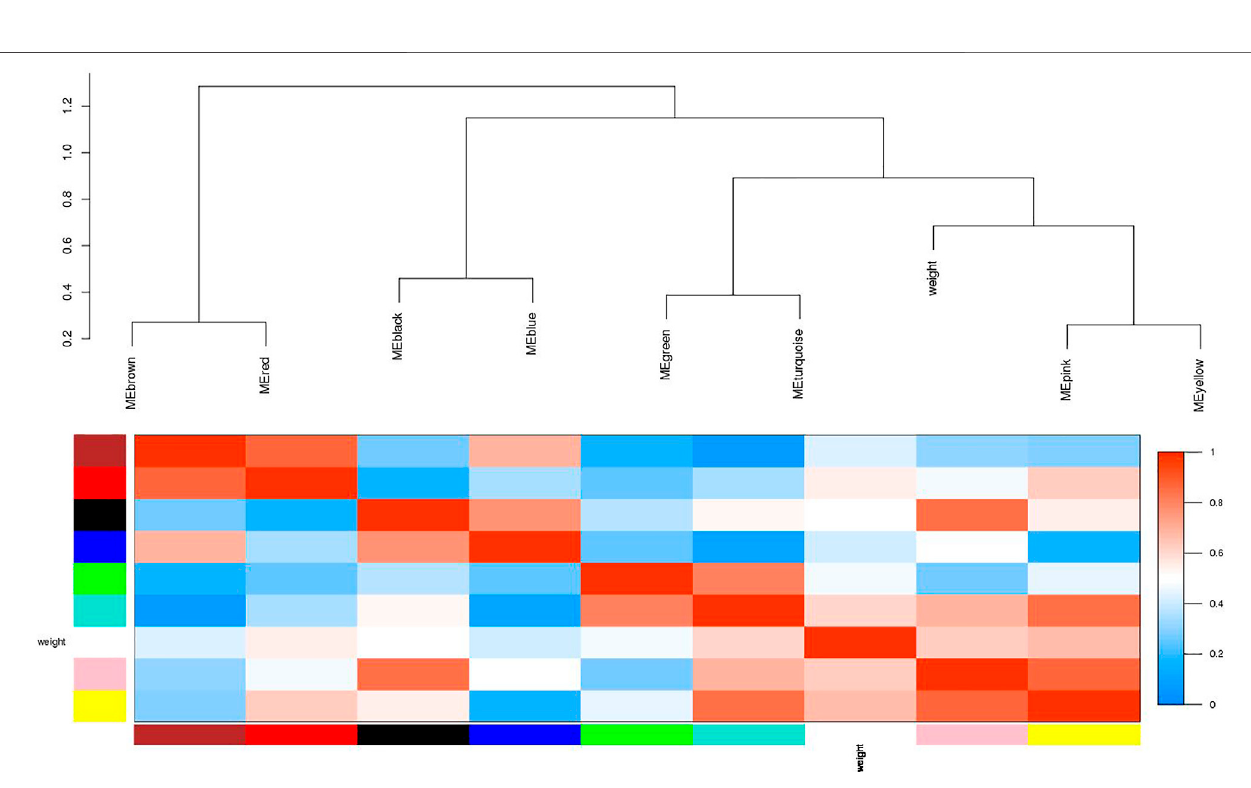
Frontiers in Genetics |